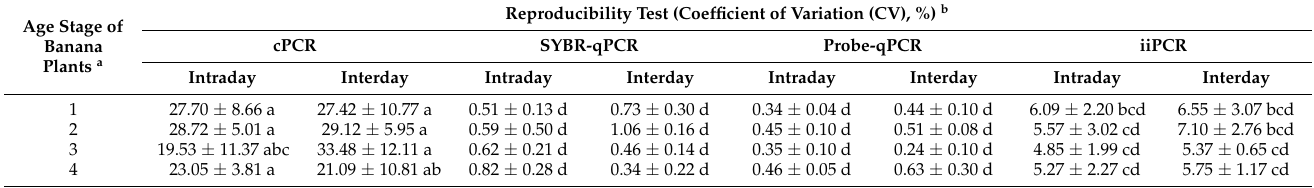
Table 9. Reproducibility evaluation of the molecular detection assays using as testers different age stages of banana plants with mild symptoms of Fusarium oxysporum infection. The testers were extracted by rapid DNA